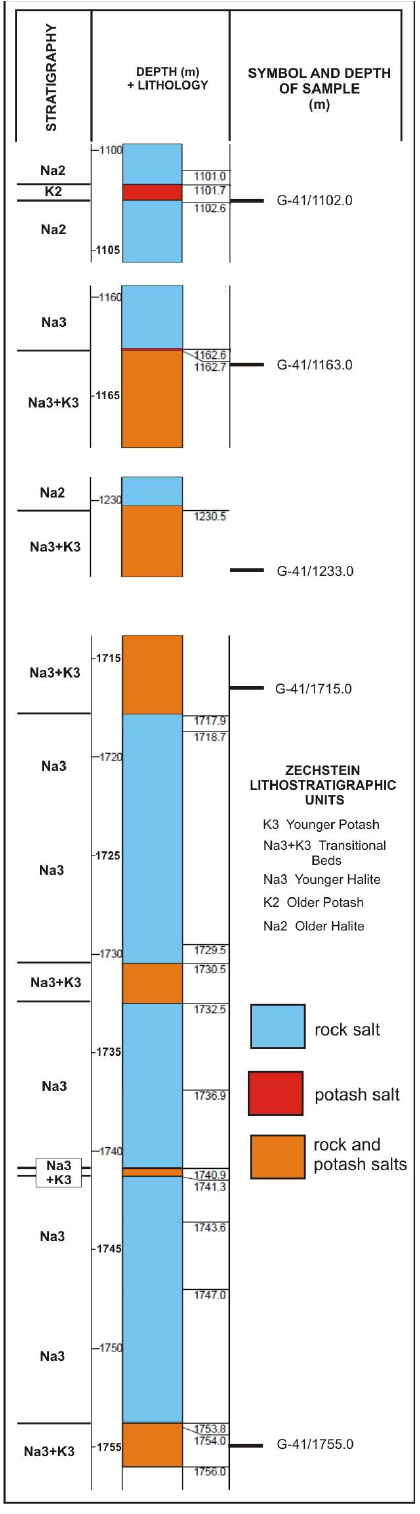
Figure 7. Sampled parts of the G-41 borehole profile with K2 and Na3+K3 lithostratigraphic units, G ó ra salt